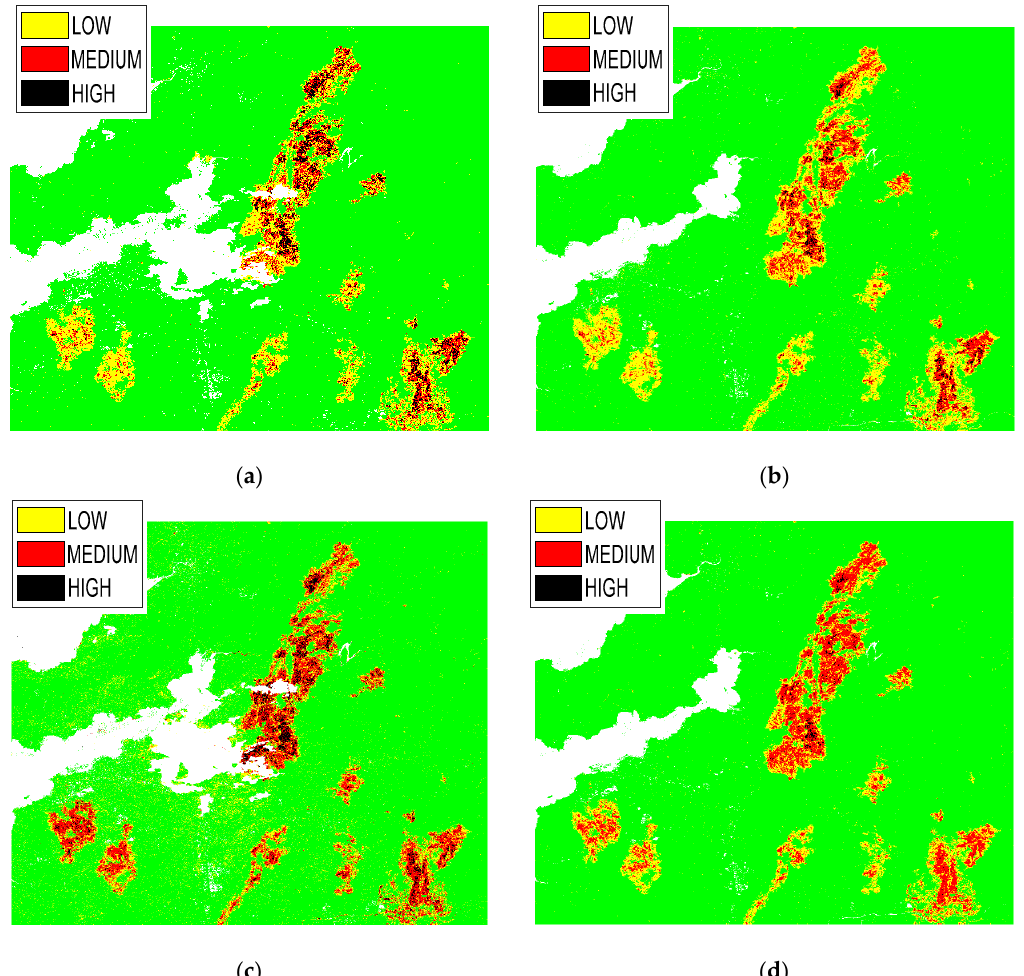
Figure 5. ( a ) Sentinel-2 dNBR image classified; ( b ) Landsat-8 dNBR image classified; ( c ) Sentinel-2 dNDVI image classified; ( d ) Landsat-8 dNDVI image classified.